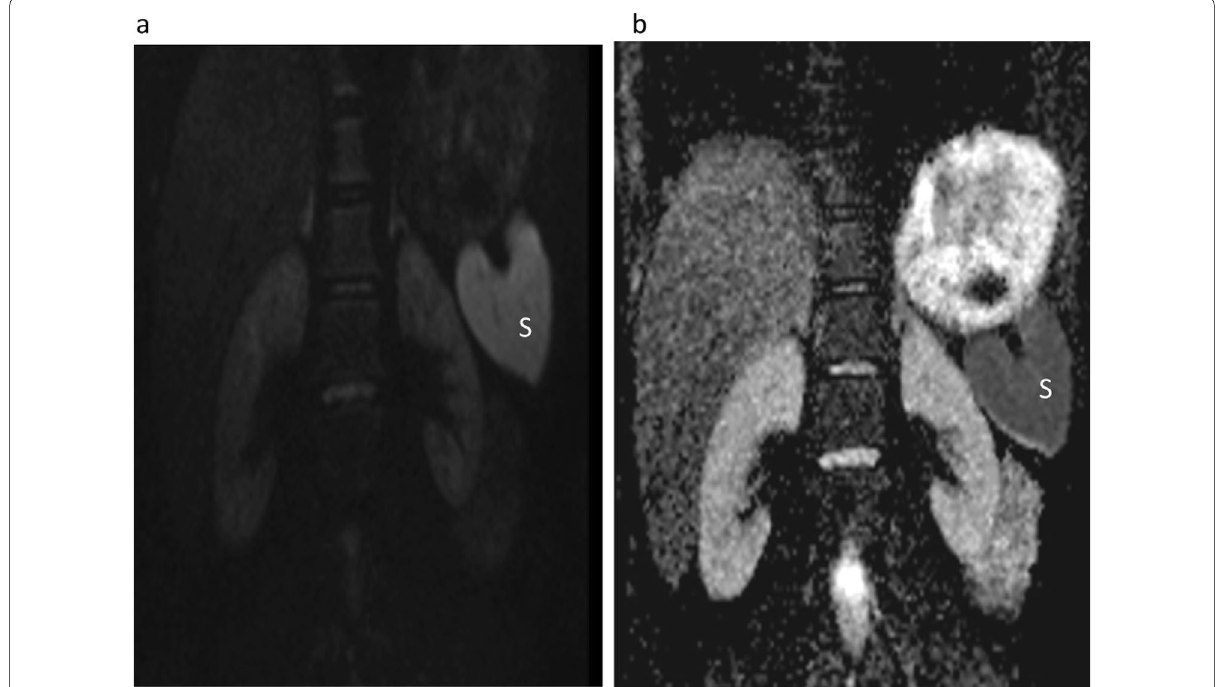
Fig. 1 Example of normal appearance of both kidneys on the diffusion-weighted image. Normal kidneys with high b value are of low signal intensity compared with spleen as a reference. ADC map ( b ), both kidneys exhibit high signals when compared with the spleen, which showing low signal compared with high b value